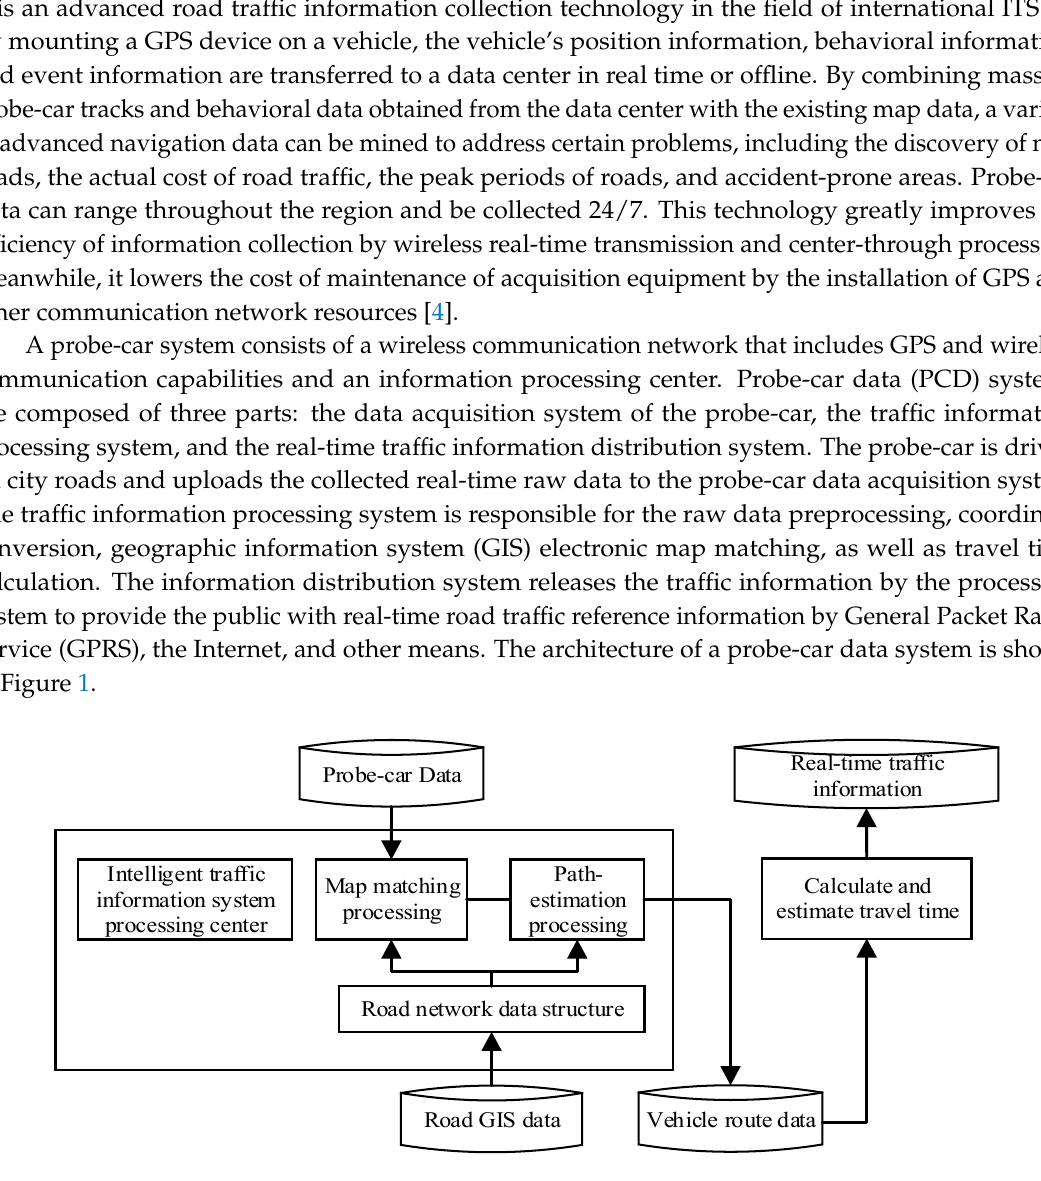
Figure 1. Technical architecture of a probe-car system.